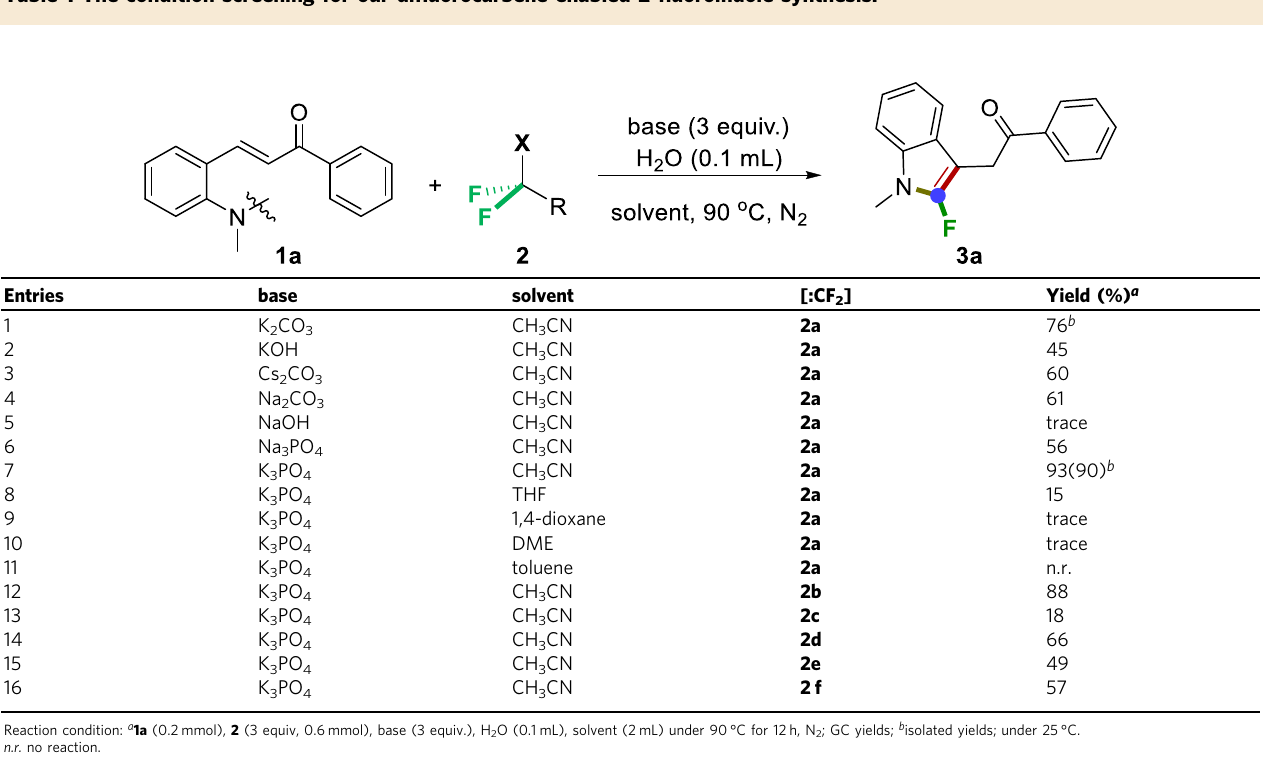
Table 1 The condition screening for our di fl uorocarbene-enabled 2- fl uoroindole synthesis.